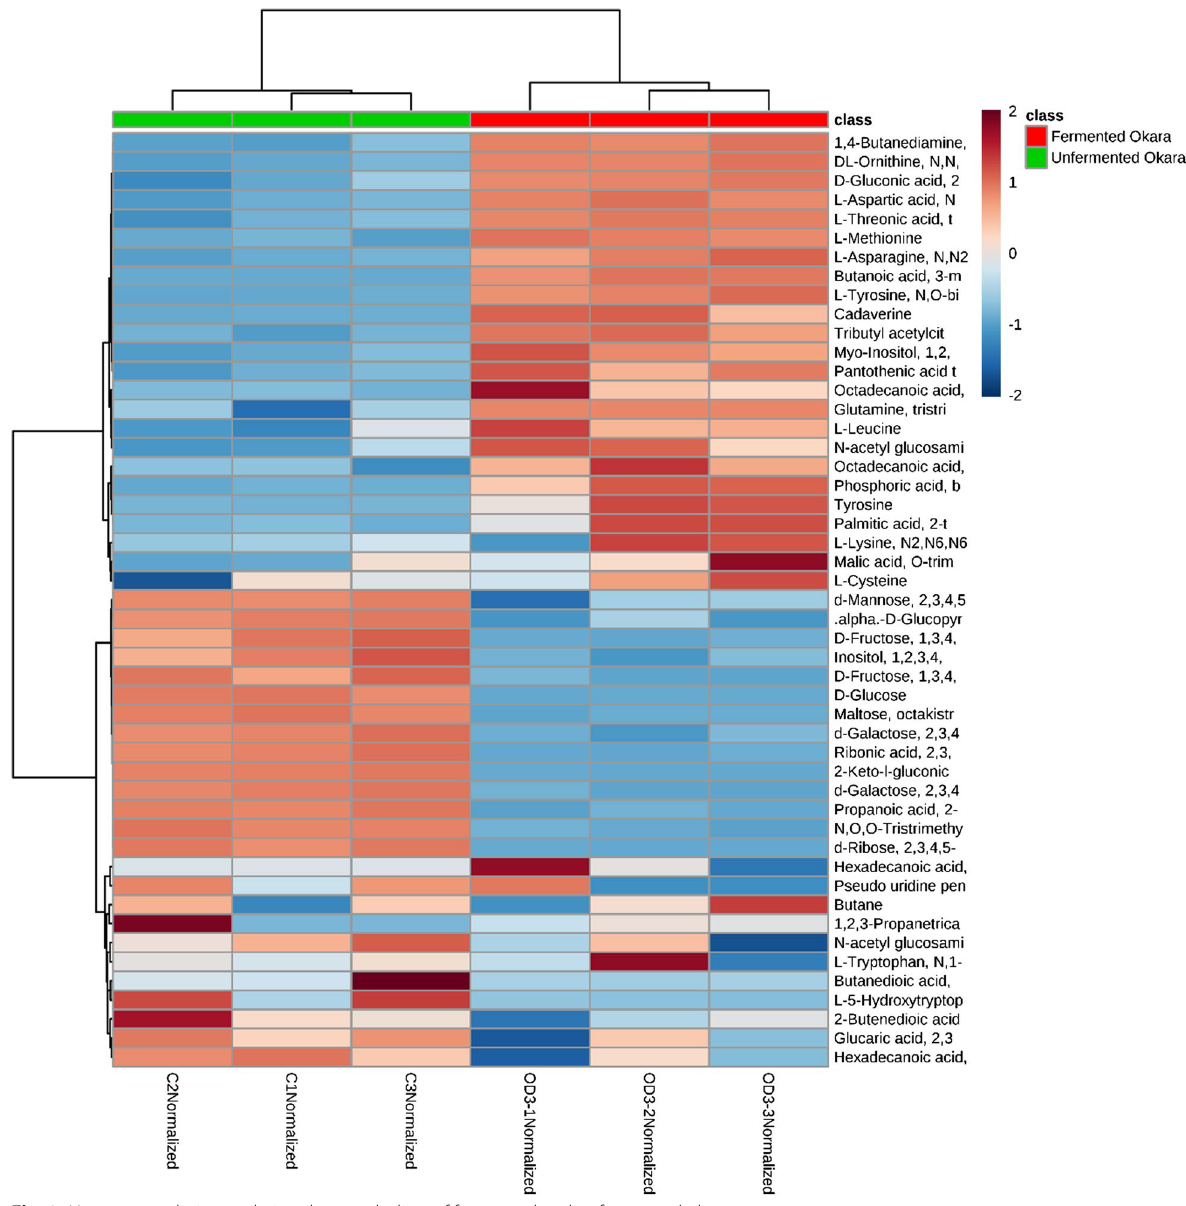
Fig. 2 Heatmap analysis correlating the metabolites of fermented and unfermented